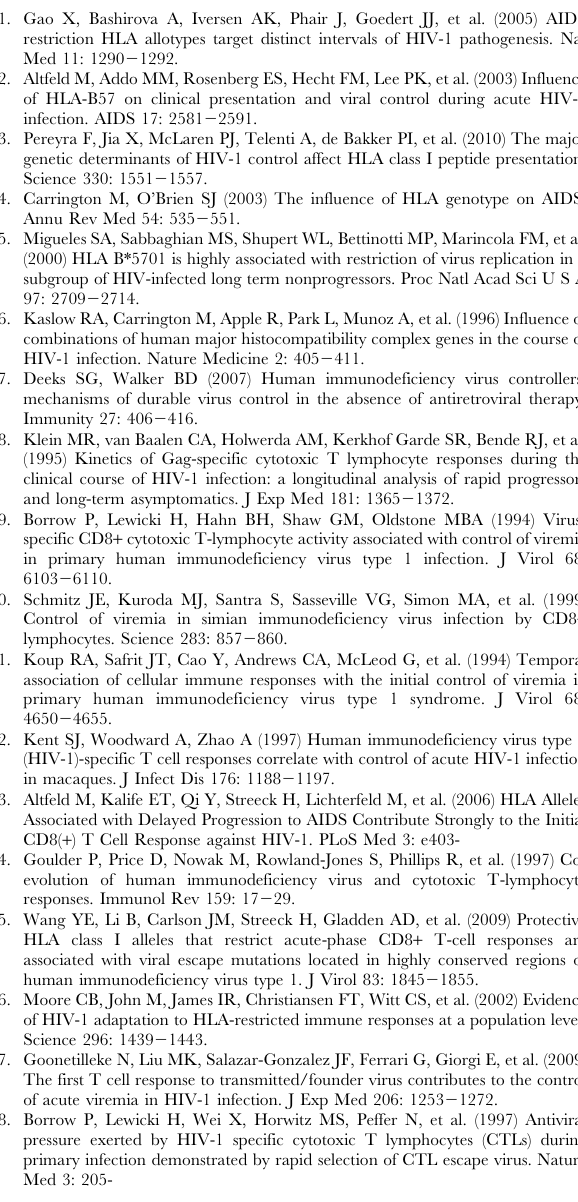
Table S1 Amino acid sequence variation in Gag. A. Sequence variation within Gag located at amino acid positions associated with the presence of HLA-B*57/5801 or disease progression as identified with SH in sequences obtained from LTNPs from various time points during the course of HIV-1 infection. B. Sequence variation within Gag at amino acid positions associated with the presence of HLA- B*57/5801 or disease progression as identified with SH in sequences obtained from progressors from various time points during the course of HIV-1